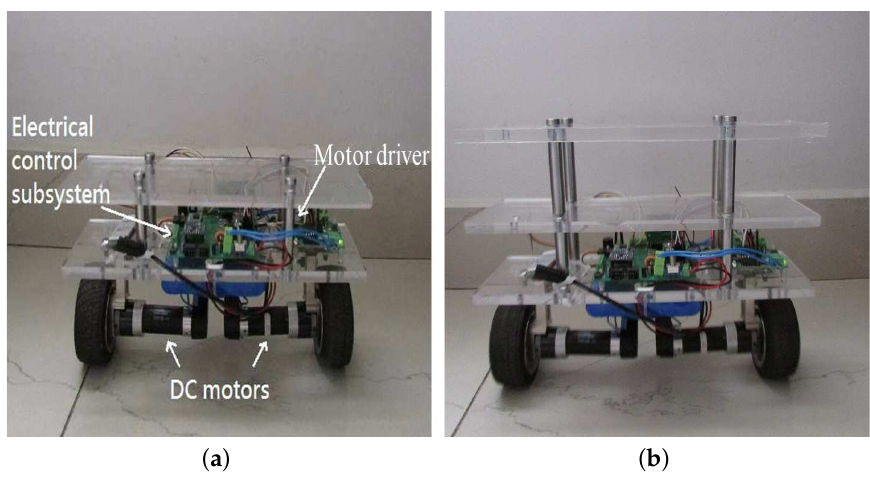
Figure 3. The real MWIP system. ( a ) Case 1: the nominal MWIP system; ( b ) Case 2: the MWIP system with model uncertainties.